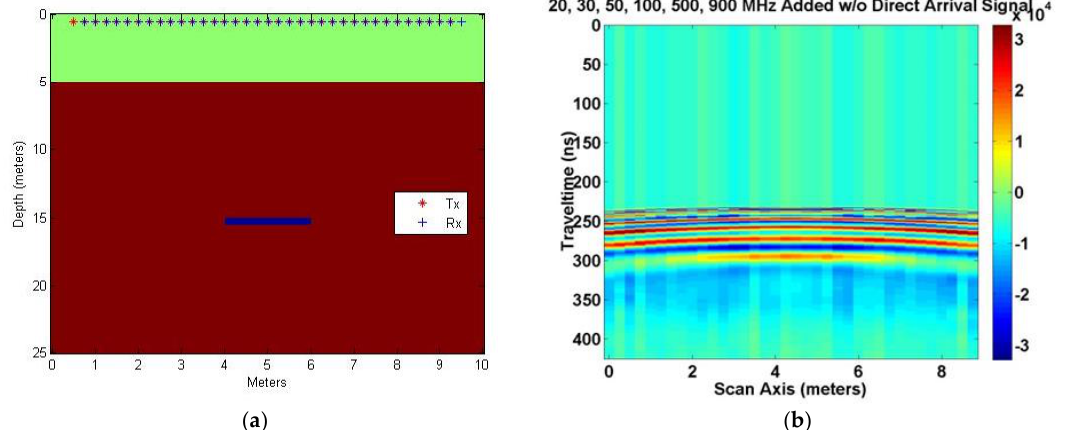
Figure 3. ( a ) Defined space with buried target at 15 m depth with transmitter/receiver (Tx/Rx) pair 5 m above ground [2–5]; ( b ) Sum of frequency signals with direct arrival and ground bounce signals removed [2,4,5].